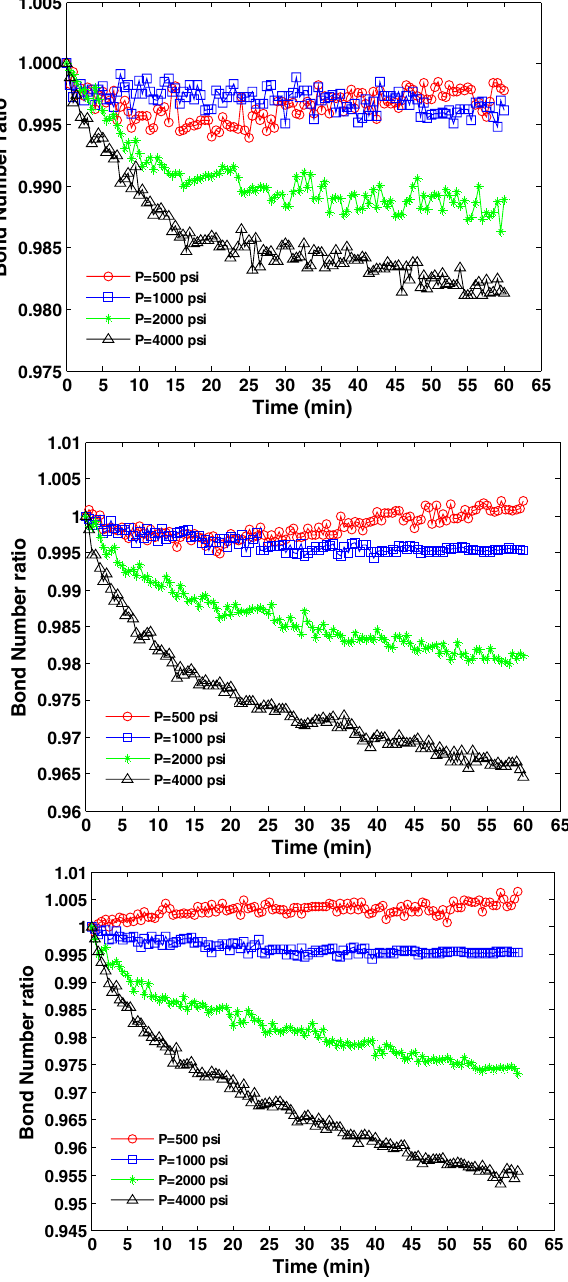
Fig. 3 Dynamic Bond number ration of crude oil in the presence of 15,000 ppm of Na 2 SO 4 at temperature of a T = 30 °C, b 50 °C, and c 80